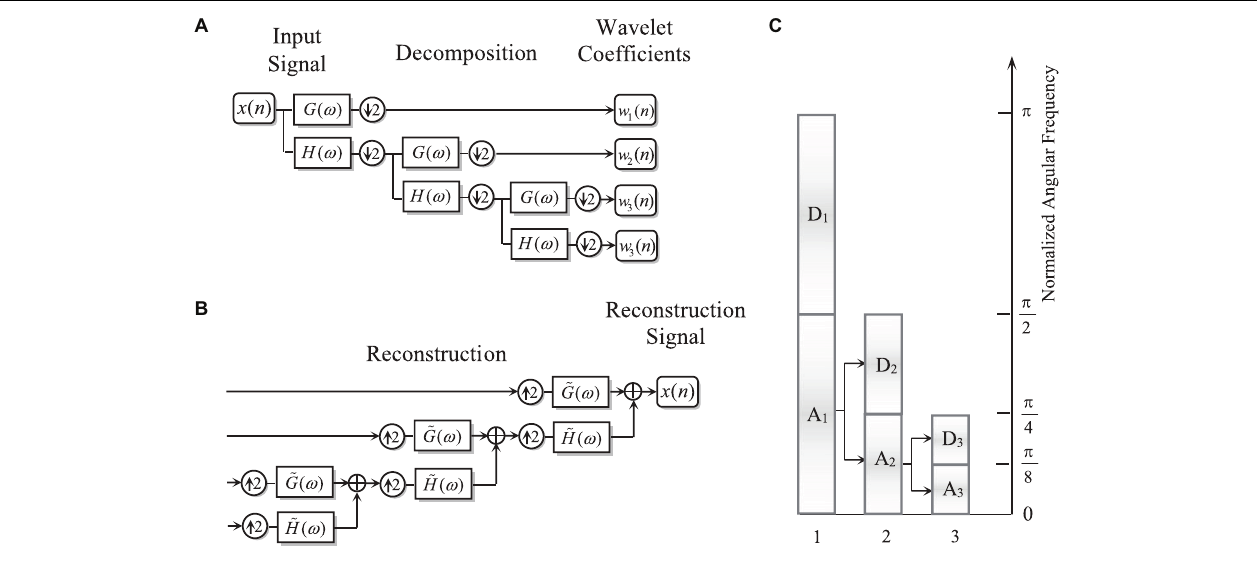
FIGURE 1 | (A) The decomposition process of wavelet transform; (B) the reconstruction process of wavelet transform; and (C) the theoretical spectral passing band of wavelet transform.